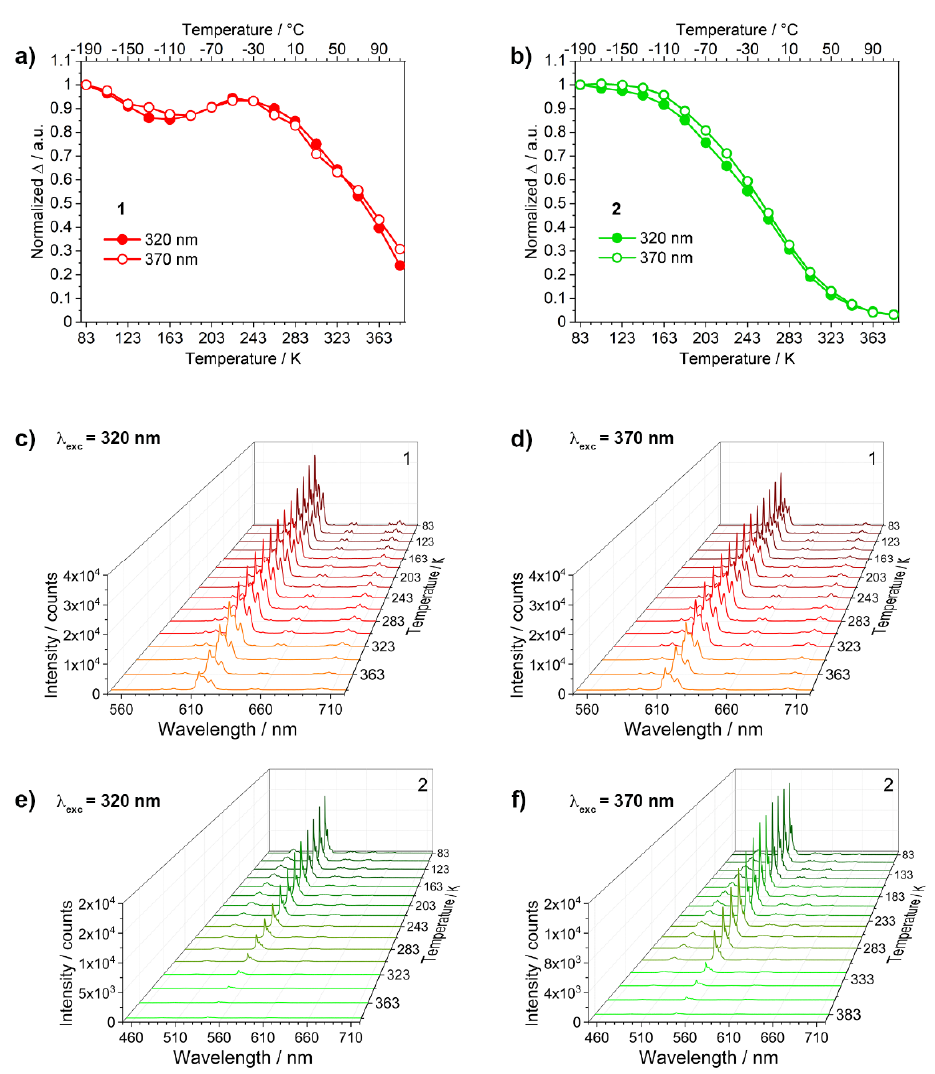
Figure 4. Comparison between the Δ curves of compounds ( a ) 1 and ( b ) 2 . λ exc = 320 nm ( ● ) and 370 nm ( ○ ). Emission spectra of 1 ( c ) λ exc = 320 nm, ( d ) λ exc = 370 nm, and 2 ( e ) λ exc = 320 nm, ( f ) λ exc = 370 nm.